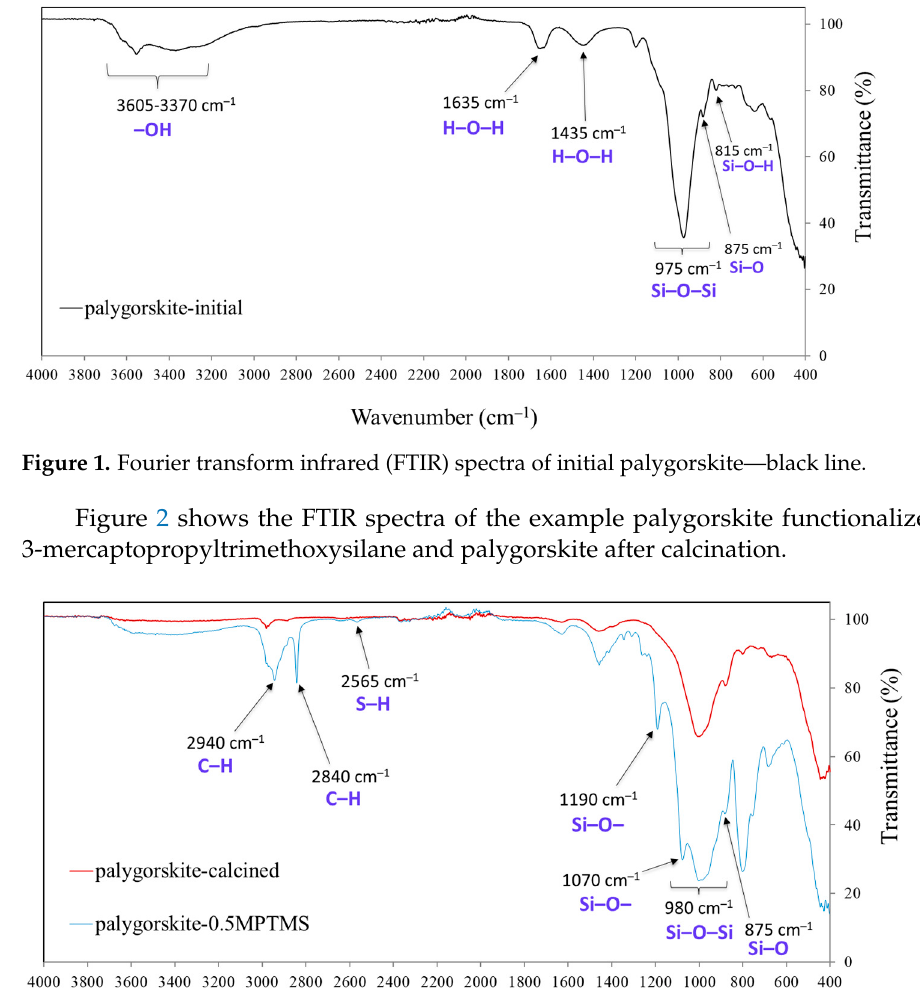
Figure 1. Fourier transform infrared (FTIR) spectra of initial palygorskite—black line.